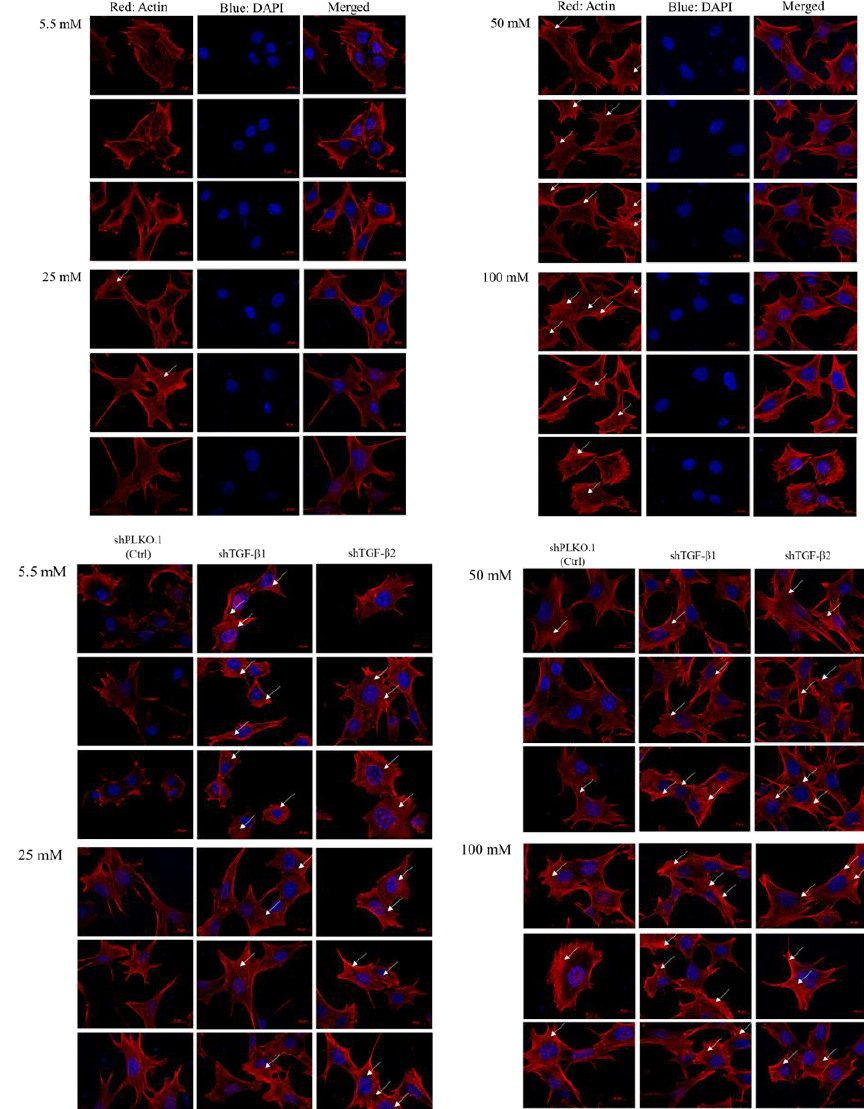
Figure 3. Immunofluorescence analysis of the activation of stress fiber and actin dots formation with 5.5 mM, 25 mM, 50 mM, and 100 mM glucose supplemented medium. RGC-5 and shPLKO.1 and shTGF-β1 and shTGF-β2 cells incubated in 5.5 mM, 25 mM, 50 mM and 100 mM glucose supplemented medium for at least 3 weeks on 12 mm-coverslips were fixed and stained with Phalloidin and DAPI (4′,6-diamidino-2-phenylindole). Each set of fields was taken using the same exposure, and images are representative of 3 different fields. (Scale bar = 20 μm).